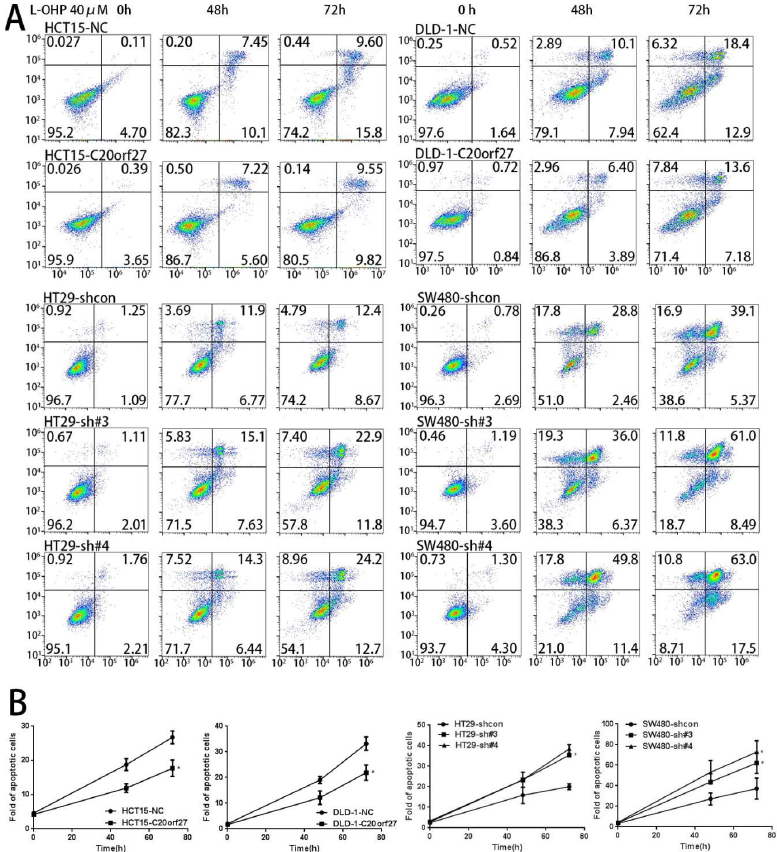
Figure 3. C20orf27 regulates apoptosis by activating the NFĸB pathway. ( A ) Cells were pretreated with L-OHP (40 μM) for 48 and 72 h. Flow cytometry analyzed apoptosis in C20orf27 overexpression and silencing cells; ( B ) Quantitative analysis of the proportion of apoptotic cells. * p < 0.05.